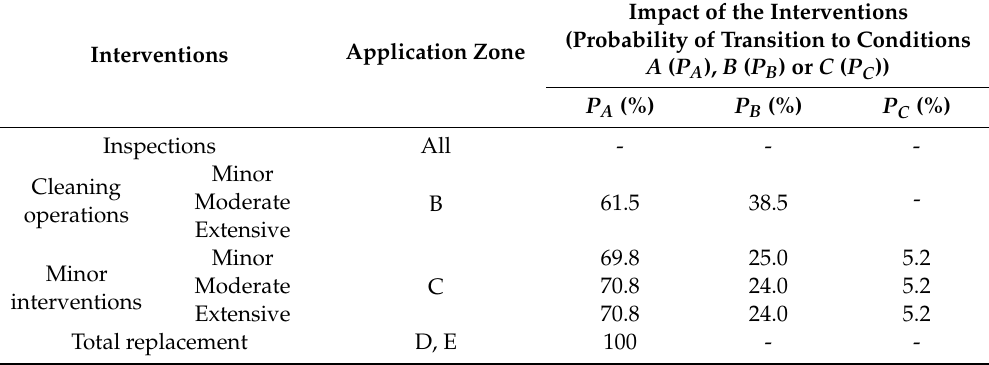
Table 6. Impacts of the